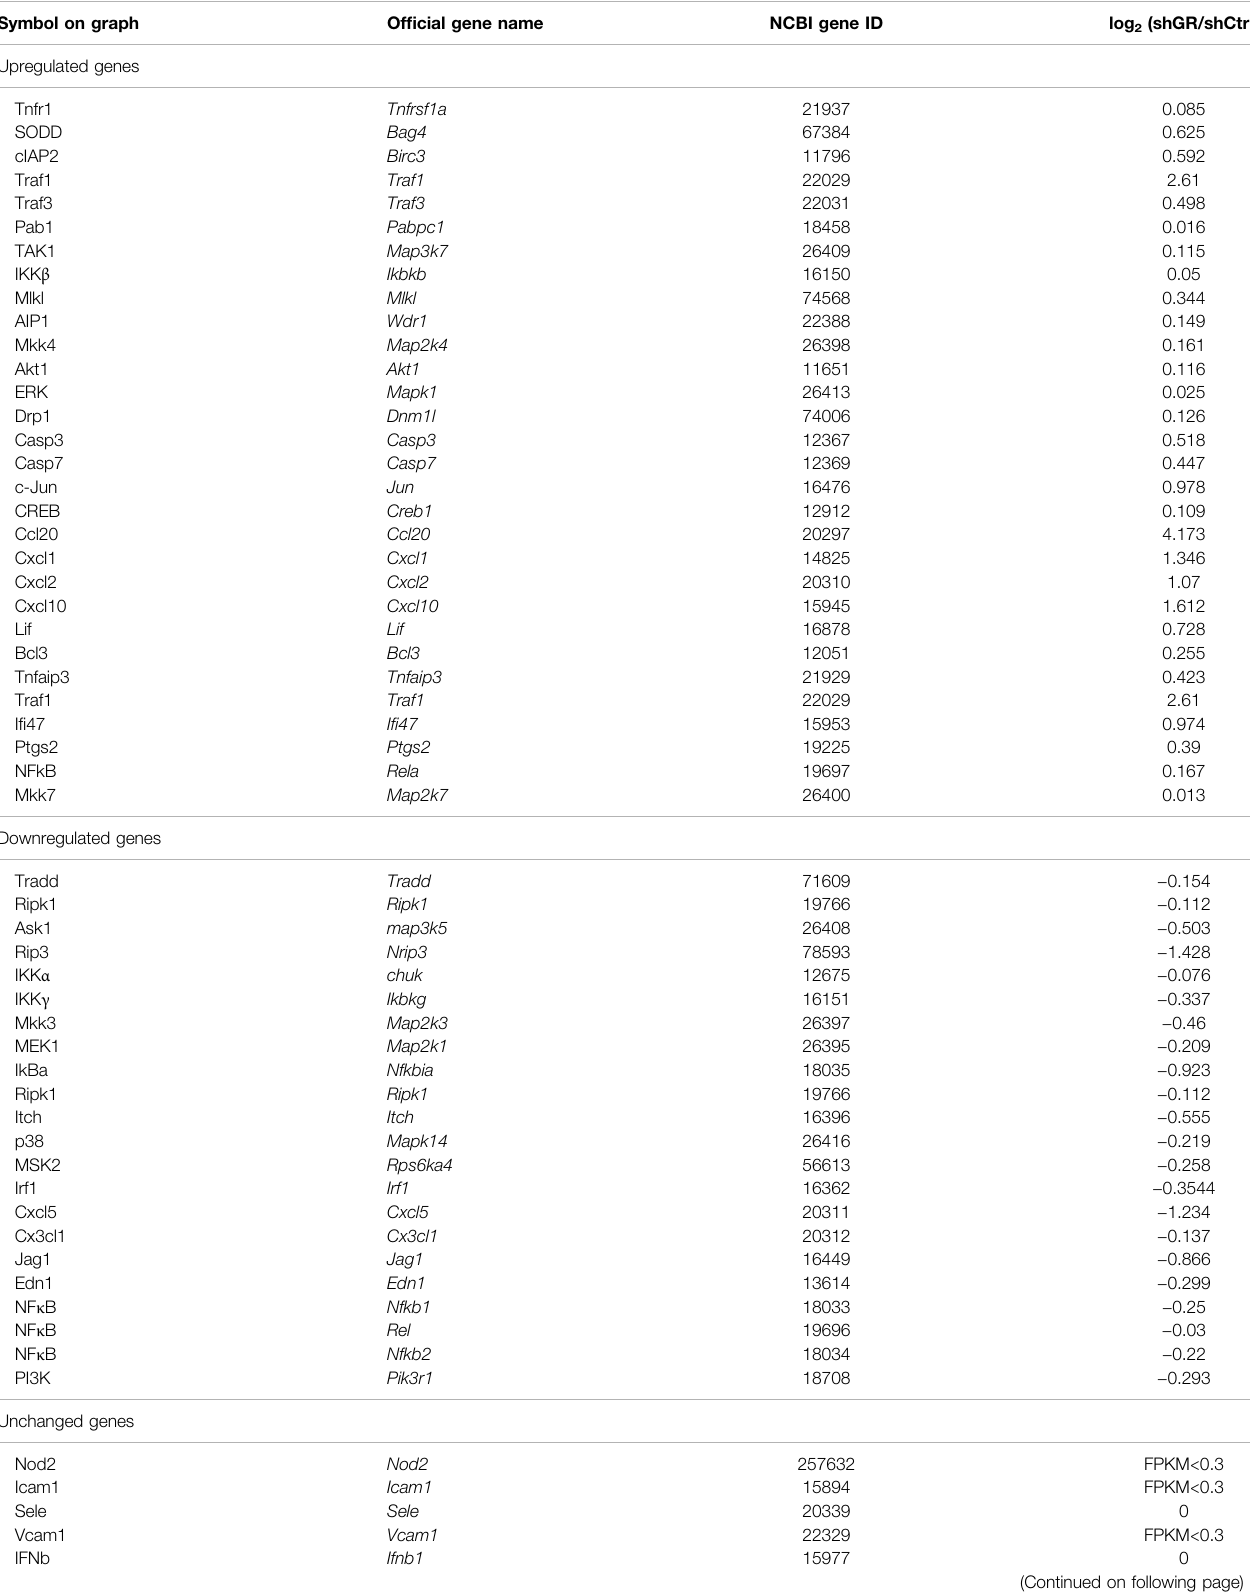
TABLE 6 | “ TNF signaling pathway ” gene table. Symbol on